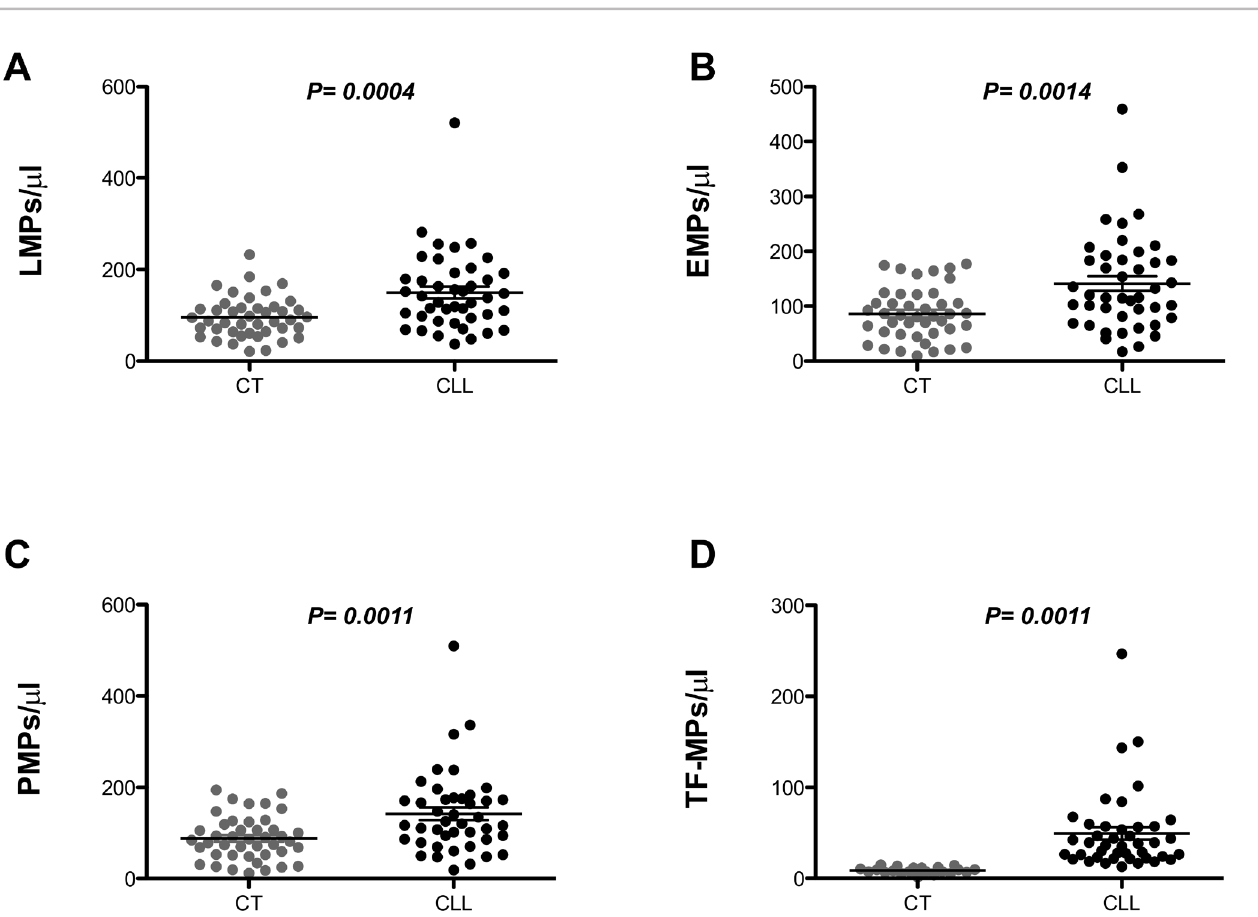
FIGURE 2 - Analysis of circulating microparticles derived from B lymphocytes (A), endothelial cells (B), platelets (C), and TF (D) in plasma samples from patients with CLL and controls (X